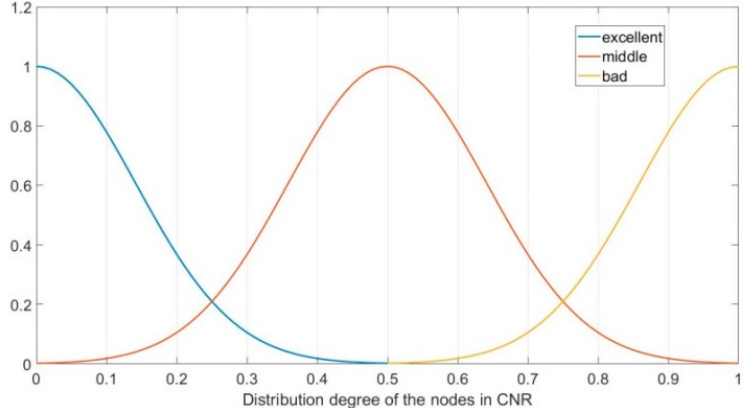
Figure 5. Subordinating degree function of parameter Ω .